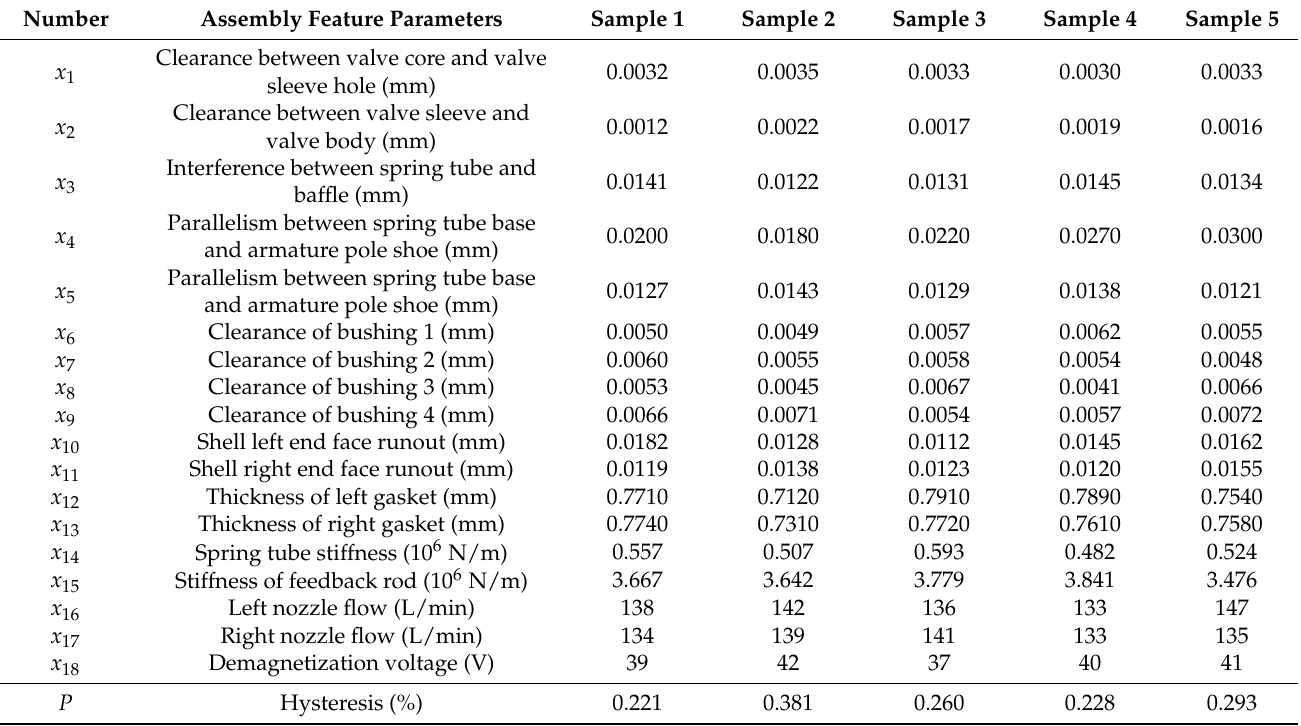
Table 3. The original data of KAFPs affecting hysteresis characteristics.